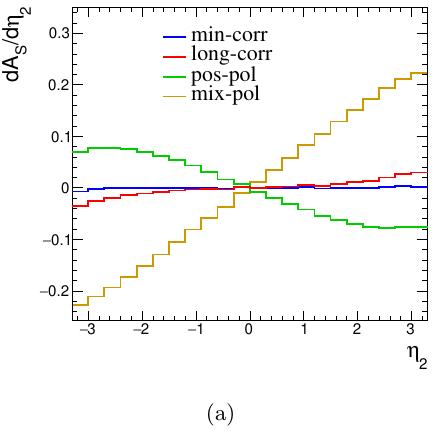
Figure 5 . The distribution of the asymmetry (4.3) as a function of the second muon rapidity. displayed in (cid:12)gure 5. The curve of the uncorrelated scenario is expected to be constant and zero over the entire range of (cid:17) , by the de(cid:12)nition (4.3). This is true for the line 2